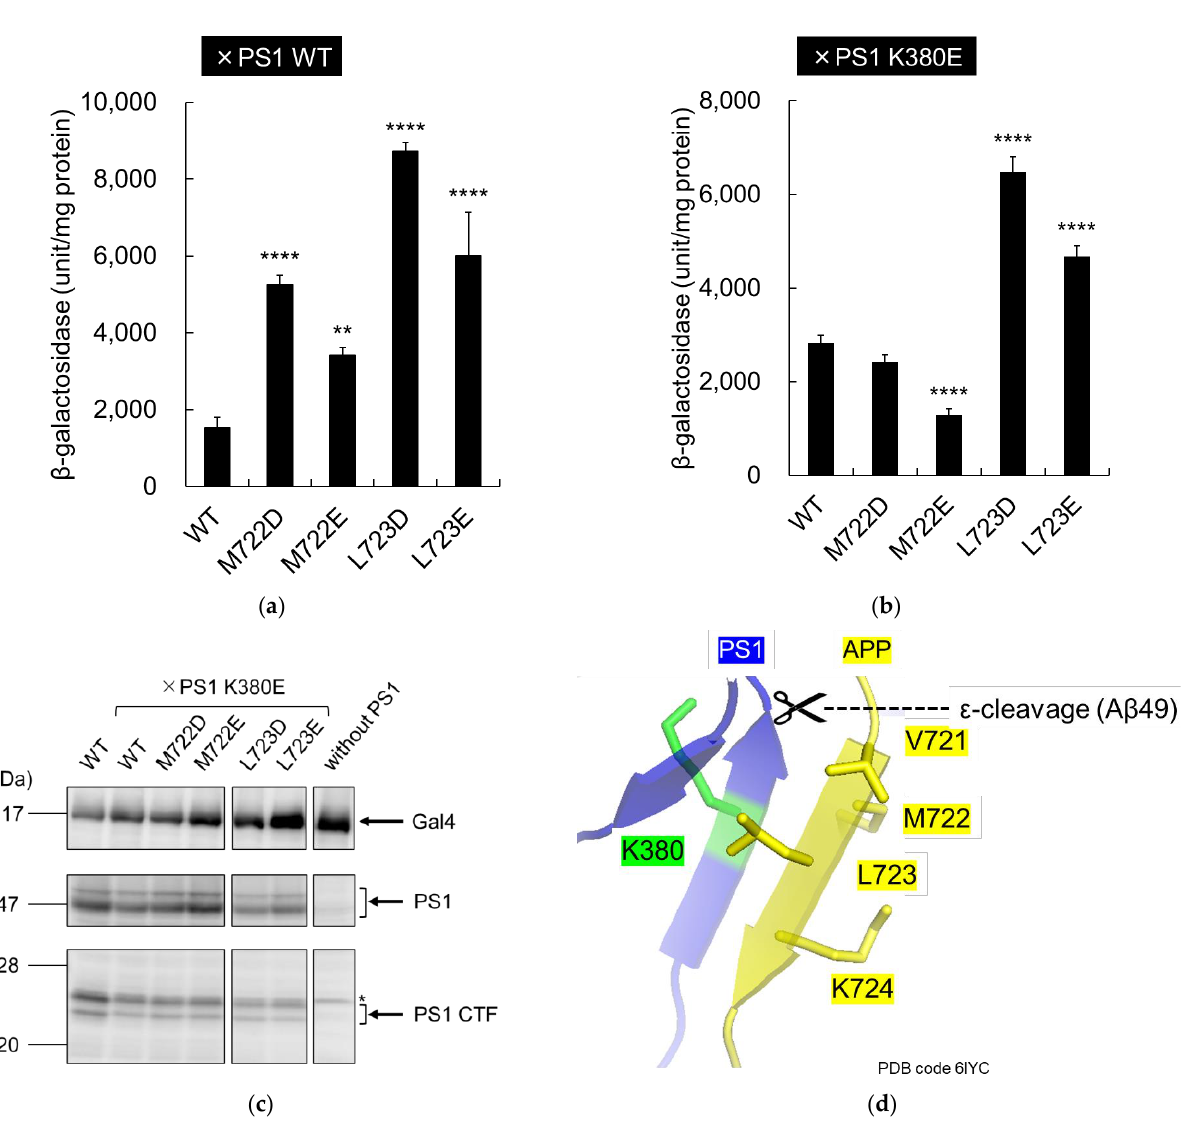
Figure 6. Structural basis for the activation of APP aspartate and glutamate mutations. ( a ) β-Galac- tosidase activity was assayed for each cell expressing WT or mutant APPC55-Gal4p with PS1 WT. Activity was normalized to that of the control cells without PS1 (63 units/mg protein); ( b ) β-Galac- tosidase activity was assayed for each cell expressing WT or mutant APPC55-Gal4p with PS1 K380E. Activity was normalized to that of the control cells without PS1 (88 units/mg protein). Asterisks indicate p < 0.0001 (****) and p < 0.01 (**) compared to the WT; ( c ) The expression of WT or mutant APP or PS1 in yeast. Cell lysates were analyzed by immunoblotting using an antibody against the activation domain of Gal4 or the PS1-loop region (GIL3). An asterisk denotes nonspecific bands. Arrows indicate the positions of Gal4, PS1, and the PS1 C-terminal fragment (CTF); ( d ) The position of APP and PS1 mutations. The structure of human PS1-APP (Protein Data Bank code: 6IYC) is shown in yellow (APP) and blue (PS1). PS1 K380 is highlighted in green. Table 2. Summary of the effects of APP aspartate and glutamate mutants. In Figure 6a,b, each APP WT was defined as one. This table indicates how many times more active the aspartate mutants (M722D and L723D) and glutamate mutants (M722E and L723E) were than the WT. The value is expressed as the average of three independent assays ± 95% confidence interval.